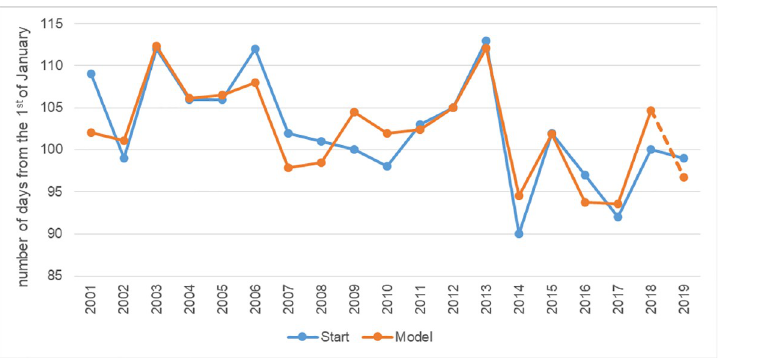
Fig 1. The plot of observed and predicted values of birch pollen season start.